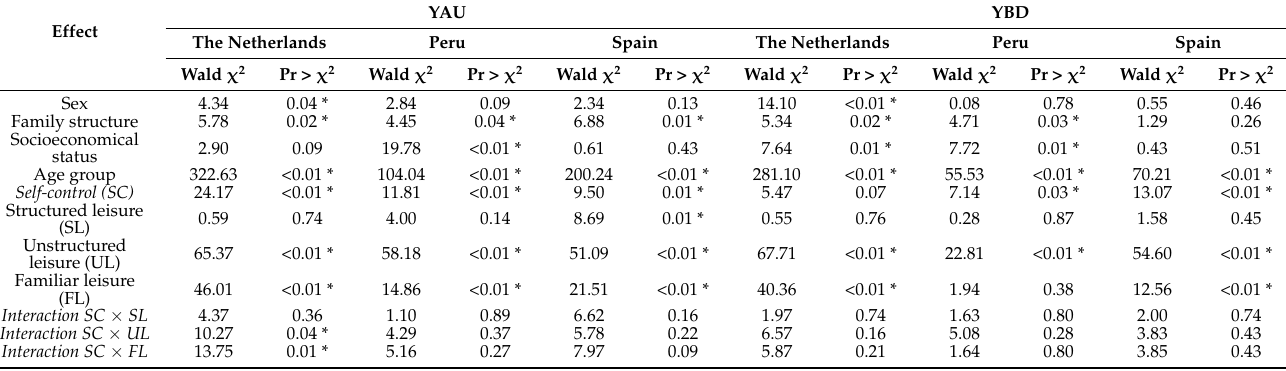
Table 6. Analysis of the maximum likelihood estimators of the model with simple effects and interactions between types of